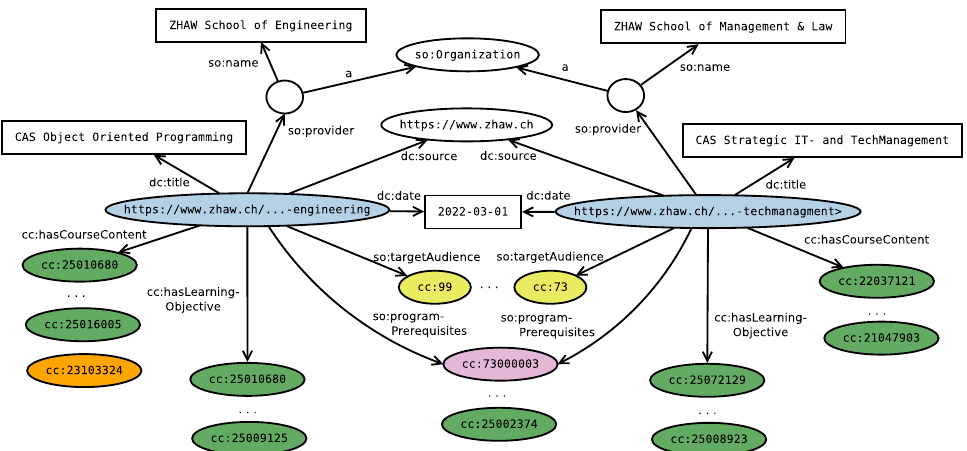
Figure 7. Visualization of the extracted knowledge graph for two continuing education offers provided by the Zurich University of Applied Sciences. The visualization outlines a section of the assigned properties and replaces rdf:type properties with color coding. Blue nodes indicate education offerings, green nodes skills, orange nodes industries, yellow nodes occupations, and pink nodes